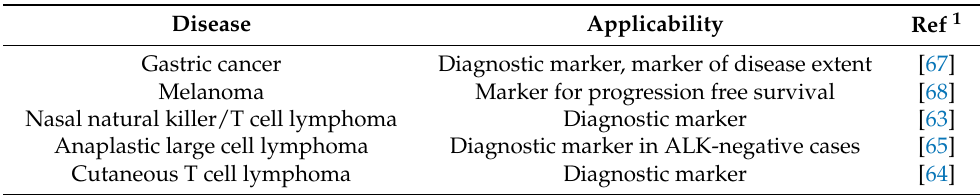
Table 1. Potential applicability of TARC in oncological diseases.